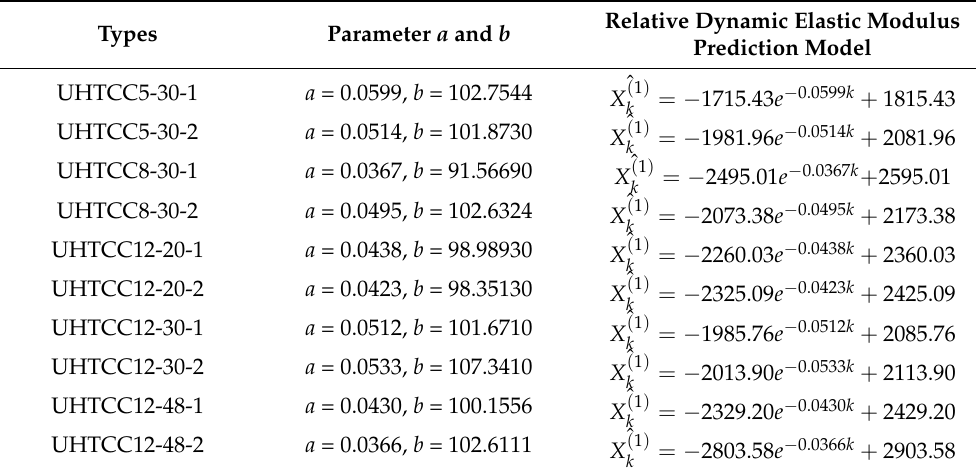
Table 7. Prediction model and coefficient of the relative dynamic elastic modulus of